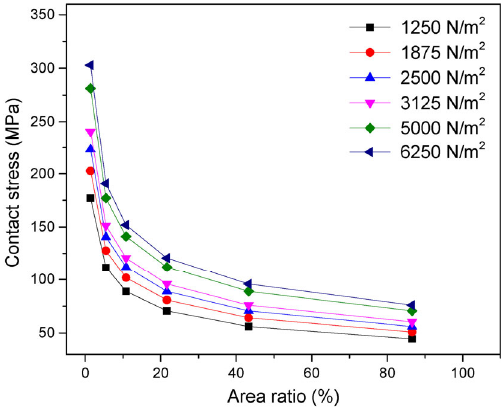
Fig. 13 The contact stress with increasing area ratio at different nominal stress.